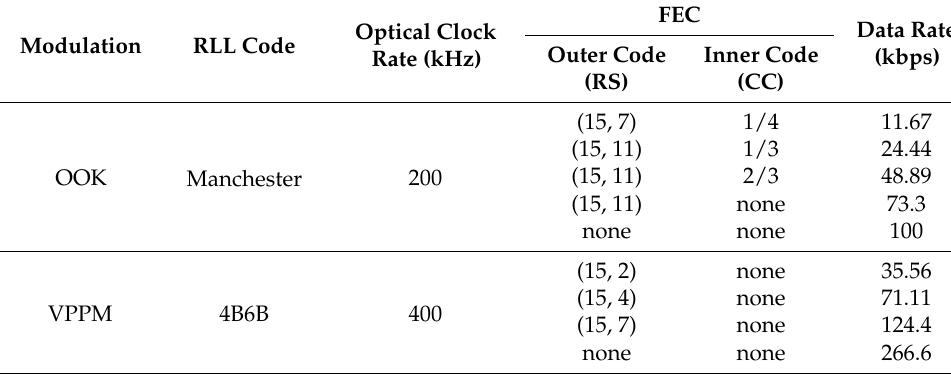
Table 1. PHY operating modes [16].